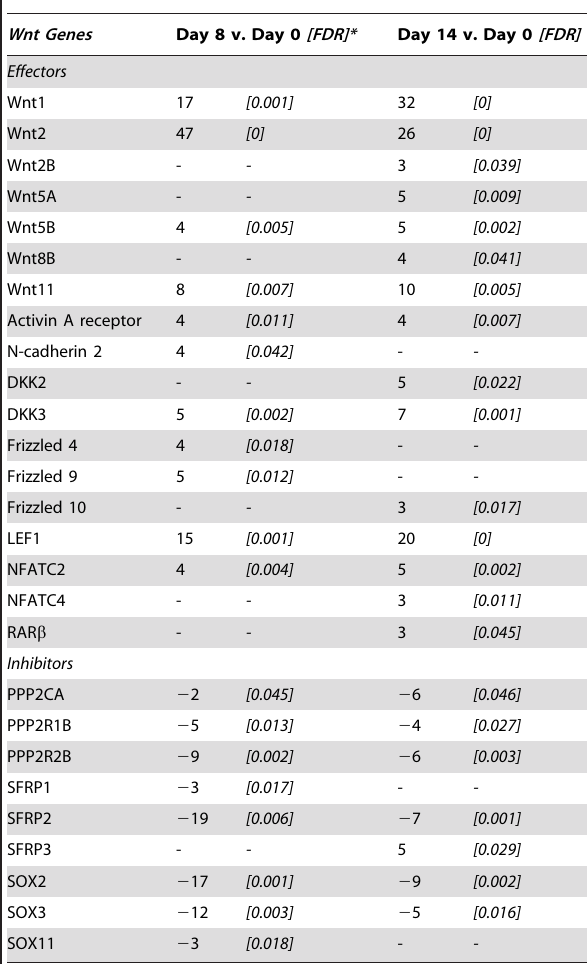
Table 2. Fold-changes in Wnt Pathway Genes.